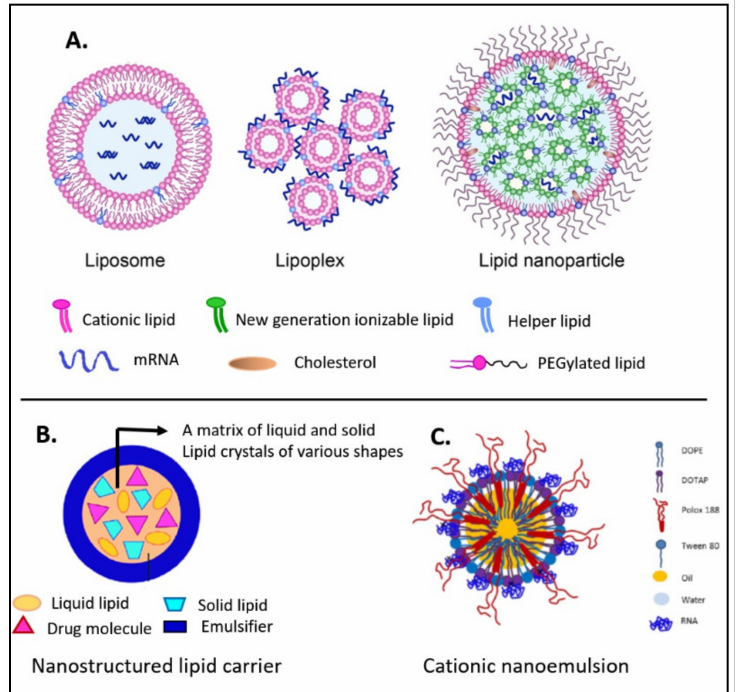
Figure 2. Key lipid nanocarriers of mRNA: ( A ) liposome, lipoplex, and lipid nanoparticle; ( B ) nanos- tructured lipid carrier; ( C ) cationic nanoemulsion (reproduced and modified from Granot et al.